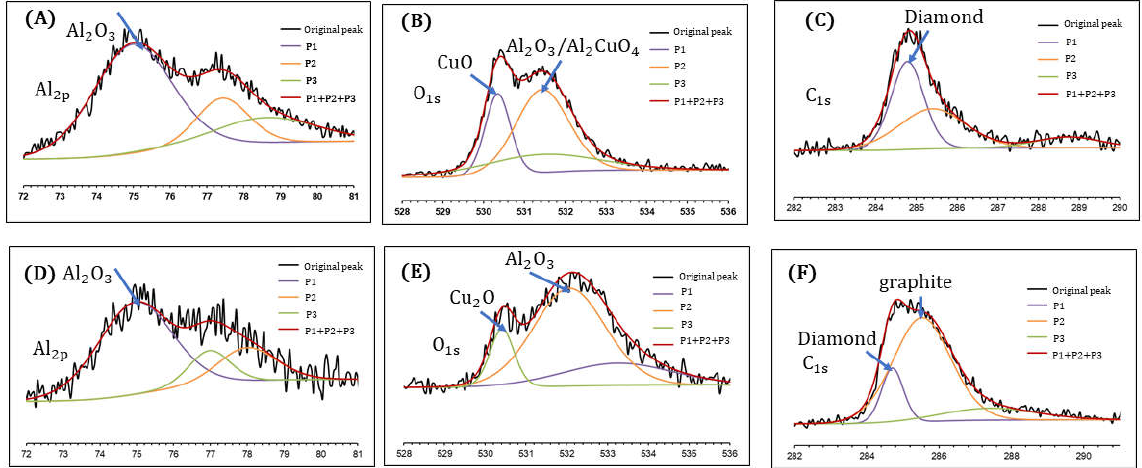
Figure 10. XPS analysis of worn surfaces of sintered copper samples ( A – C ) and sintered Cu-MgPG samples ( D – F ) against Al 2 O 3 counterbody.